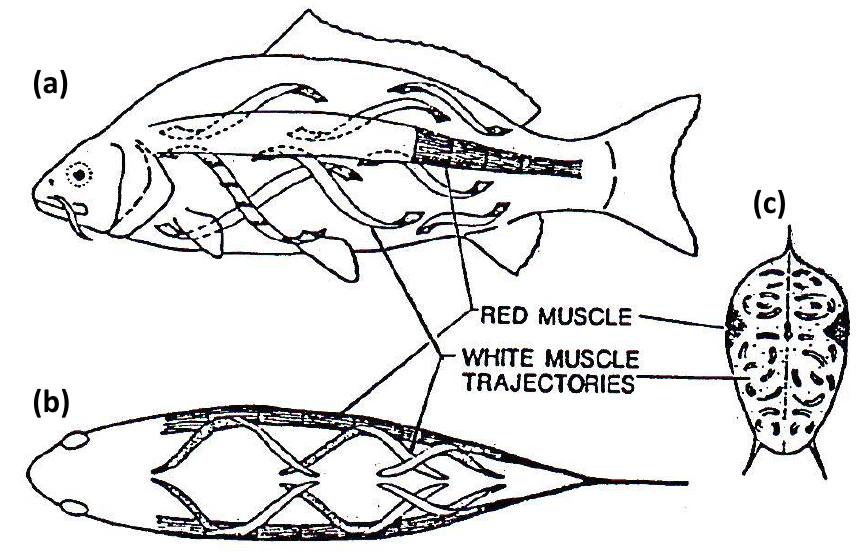
Figure 7. Muscular anatomy of the carp Cyprinus carpio in ( a ) longitudinal view, ( b ) dorsal view and ( c ) cross-sectional view. The red muscle (at the lateral line) forms a thin sheet just under the skin and extends to a depth of about 10% of the distance to the